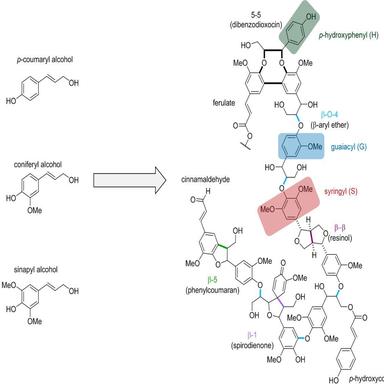
A representation of a lignin structure formed from the three major monolignols, i.e., p-coumaryl alcohol, coniferyl alcohol and sinapyl alcohol; Substructures: p-hydroxyphenyl (H) (green), guaiacyl (G) (blue) and syringyl (S) (red), dibenzodioxocin, ferulate, cinnamaldehyde, phenylcoumaran, resinol, spirodienone, phydroxycoumarate; Most common linkages: β-O-4 (blue), β-β (purple), β-5 (green), β-1 (violet), 5–5 (black). (For interpretation of the references to color in this figure legend, the reader is refe